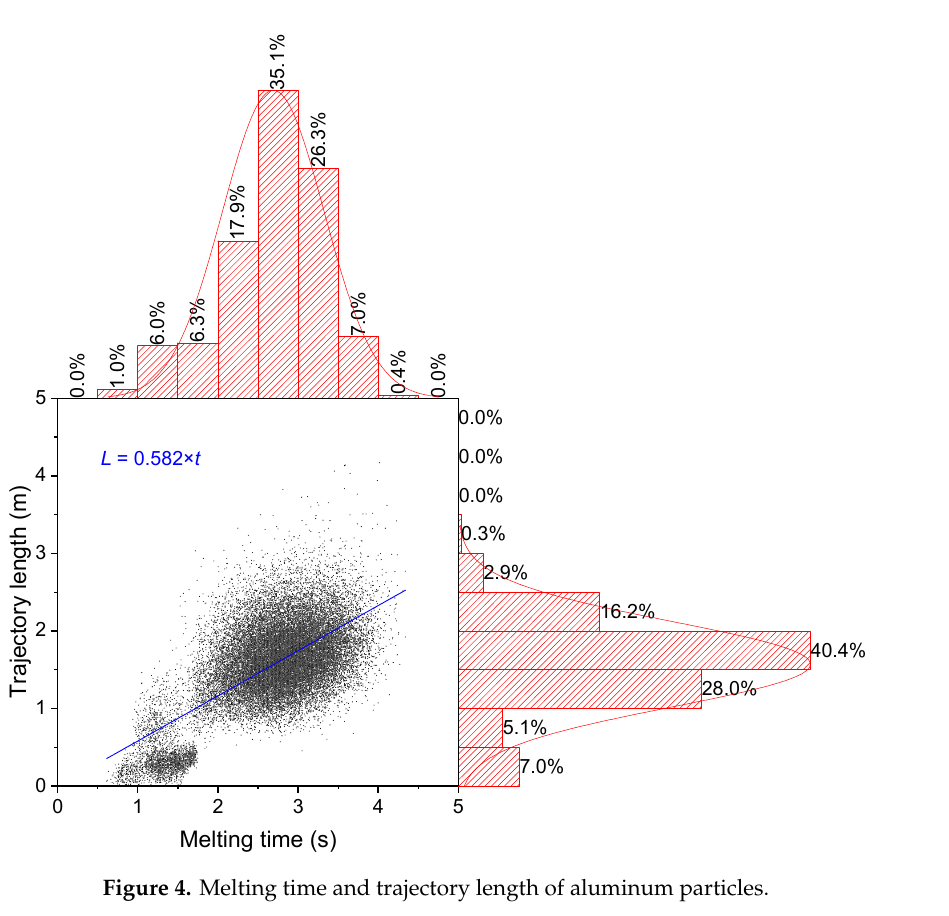
( c ) Figure 6. Variation of the dimensionless concentration of aluminum at three typical monitors: ( a ) monitors 500 mm below top surface; ( b ) monitors 300 mm below top surface; ( c ) monitors 100 mm below top surface. Table 2. Mixing time results for different monitors. Positions